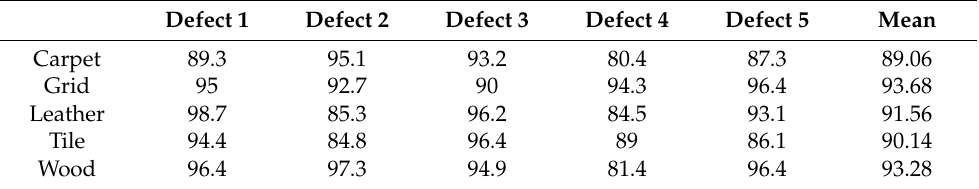
Table 11. Final results of texture error detection after hybridization of